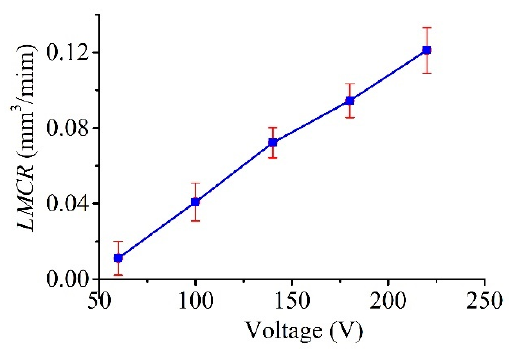
Figure 17. Effect of open voltage V s on the MRR.